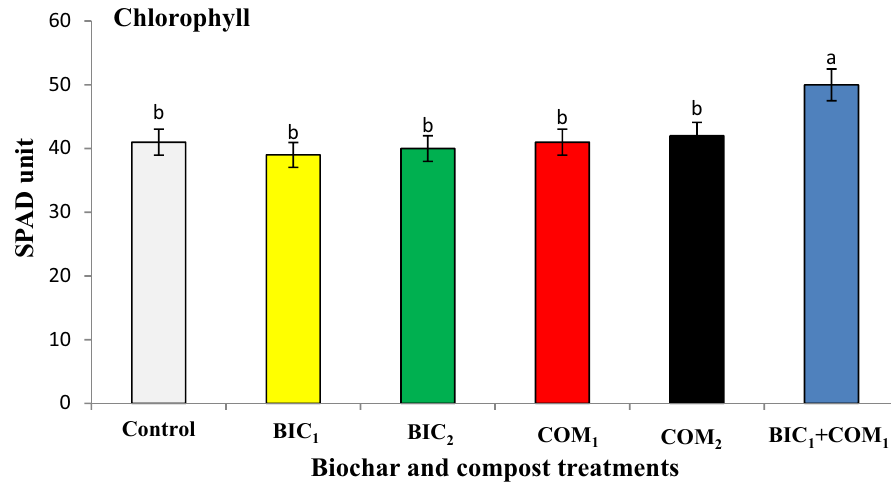
Figure 4. Effect of biochar and compost on chlorophyll (SPAD unit) in the leaves of roselle plants. BIC1 and BIC2 = biochar at rates of 1 and 2% (w/w), COM1 and COM2 = compost at rates of 1 and 2% (w/w), and BIC1 + COM1 = mixture of the two amendments at 1% (w/w) of each. Means (± SD, n = 5) denoted by the same letter indicate no significant difference according to Tukey’s multiple range tests at p <